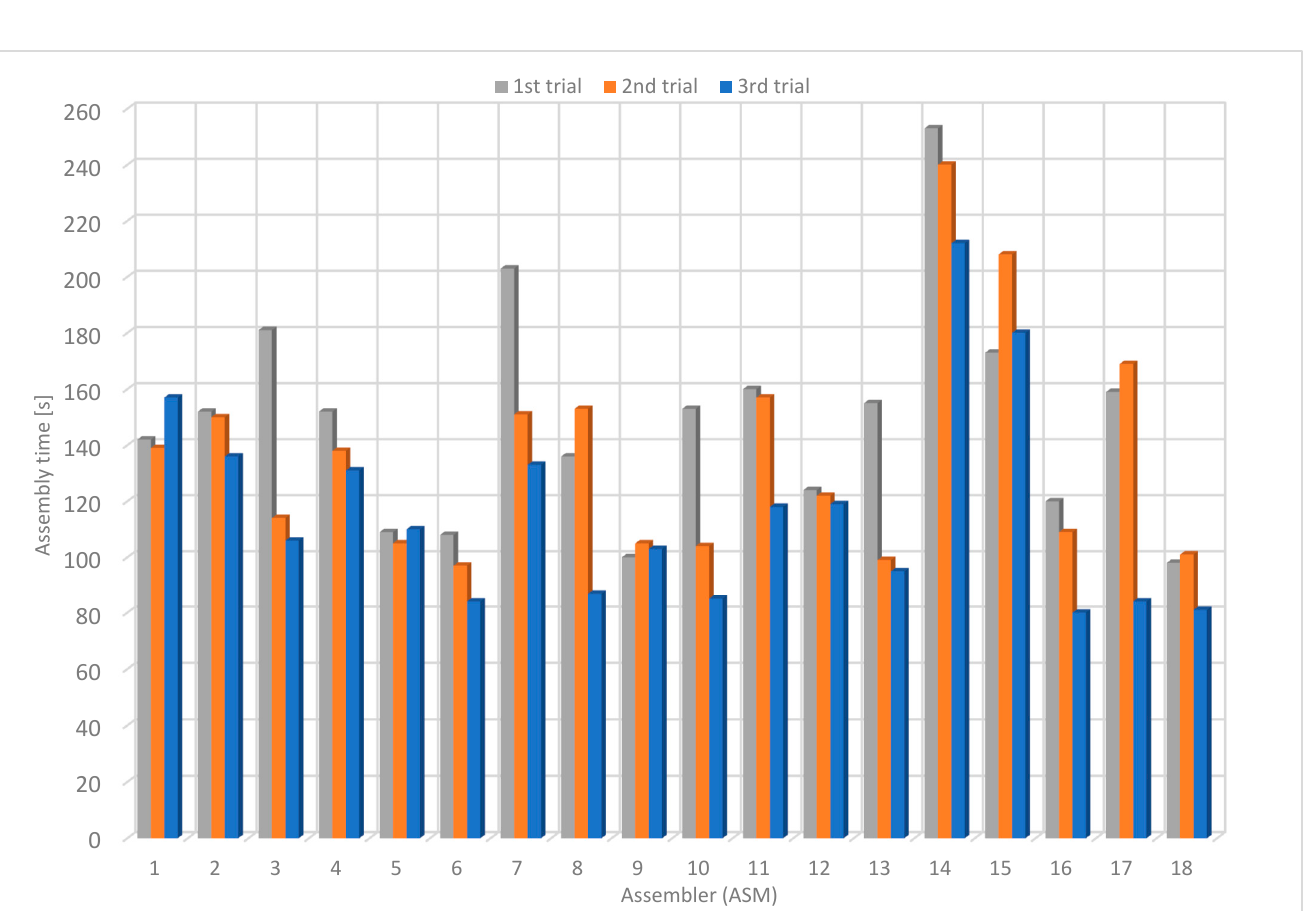
Figure 16. Assembly time using original instructions.